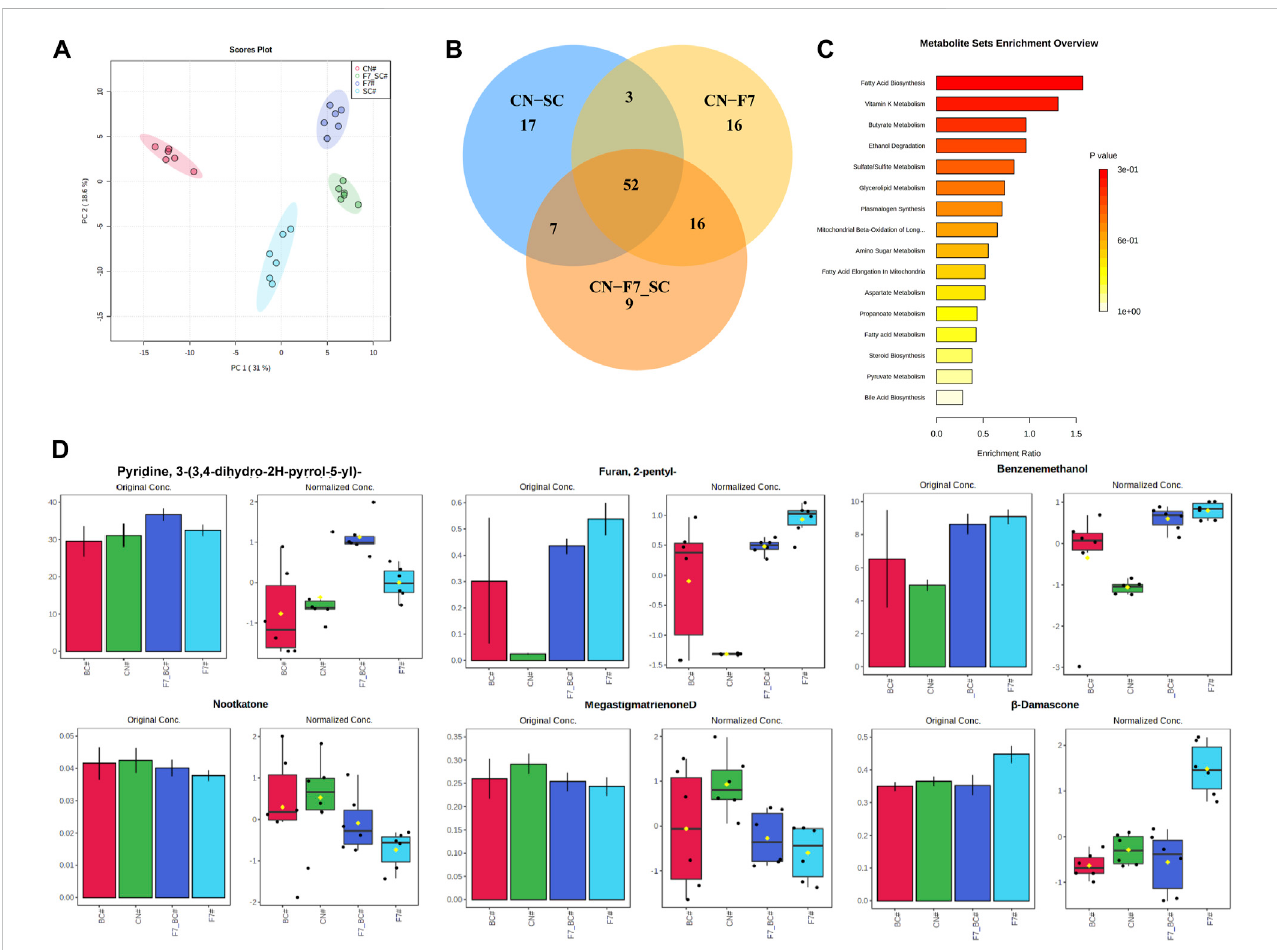
FIGURE 8 Optimization of compound culture of strains F7# and 3# (A) PCA analysis of molecular compounds from strains F7# and 3# (B) . Analysis of common differences between the combined culture and the pure cultures (C) . Differential metabolic pathways re fl ected by the differential metabolites (D) . Analysis of some aromatic components. SC was strain 3#, and F7-SC was F7#-3# combined